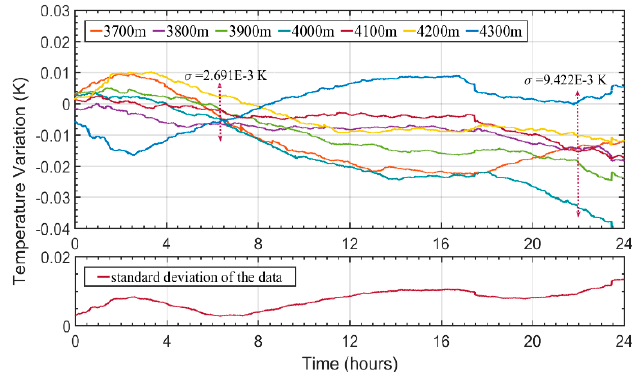
Figure 9. Difference between the temperature traces at the last positions of the fiber and the average temperature behavior. Below, the evolution of the standard deviation between the above traces is depicted.